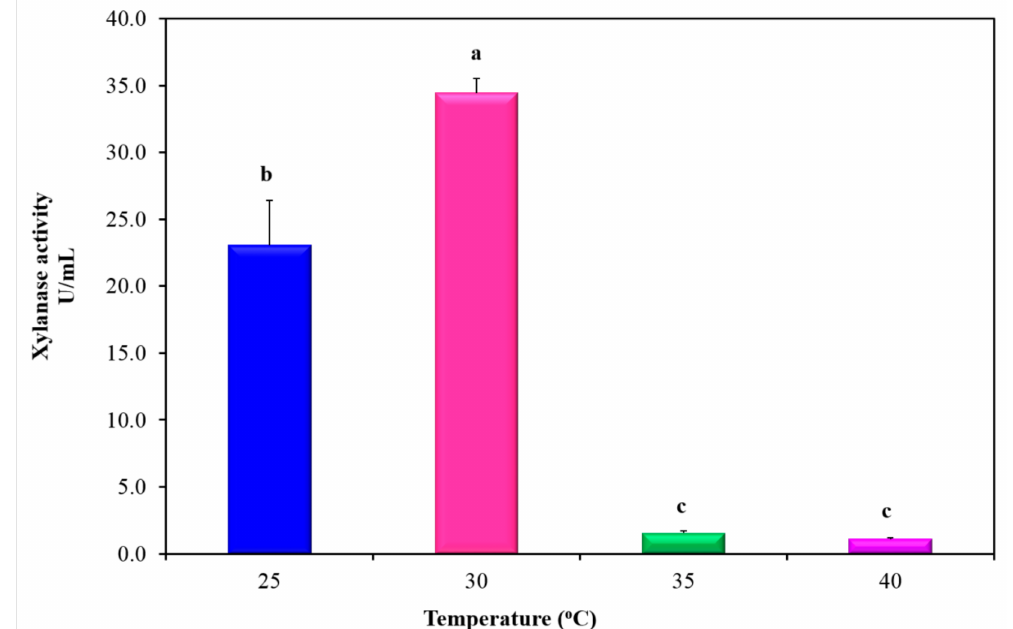
Figure 4. Influence of incubation temperature on the production of xylanase from P. chrysogenum A3 DSM105774 using minimal medium complemented with WS (0.5% ( w / v )) for 6 days. Values are mean of 4 readings ± standard errors. Symbols (a, b, and c) displayed on histogram bars were used to distinguish the significance in the xylanase levels imposed by different inorganic nitrogen sources. The histogram bars bearing the same symbol letter indicated non-significant difference. The histogram bars bearing different symbol letters indicated a significant difference at p -value ≤